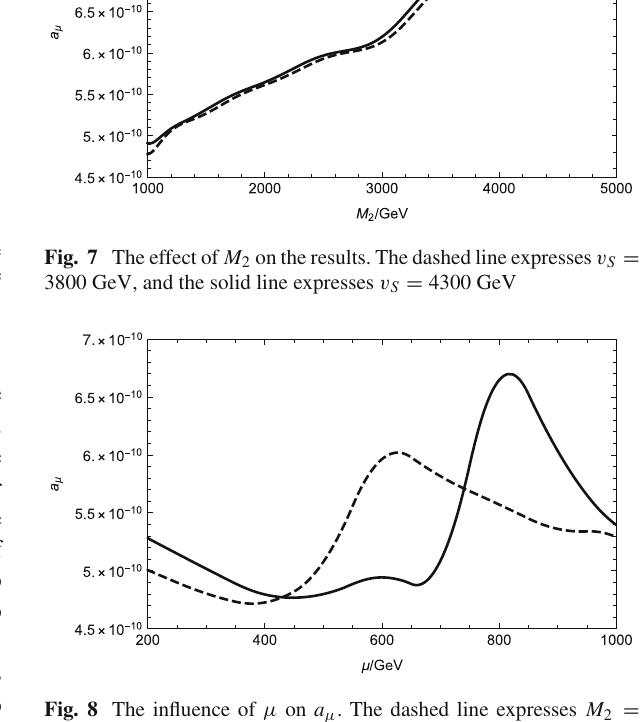
To see how μ affects the muon MDM, we suppose M S = 1200 GeV, v S = 3000 GeV, M E = 1 TeV 2 and plot the results versus μ . The solid (dashed) curve corresponds to the results obtained with M 2 = 1000 ( 800 ) GeV, which is shown in the Fig. 8. It is obvious that, μ affects a μ strongly. Their smallest value is about 4 . 7 × 10 − 10 and largest value is about 6 . 8 × 10 − 10 . When μ ia larger than 800 GeV, the both curves decrease. The dashed line expresses the result with M 2 = 800GeV,anditcomesupthelargebump( a μ = 6 . 01 × 10 − 10